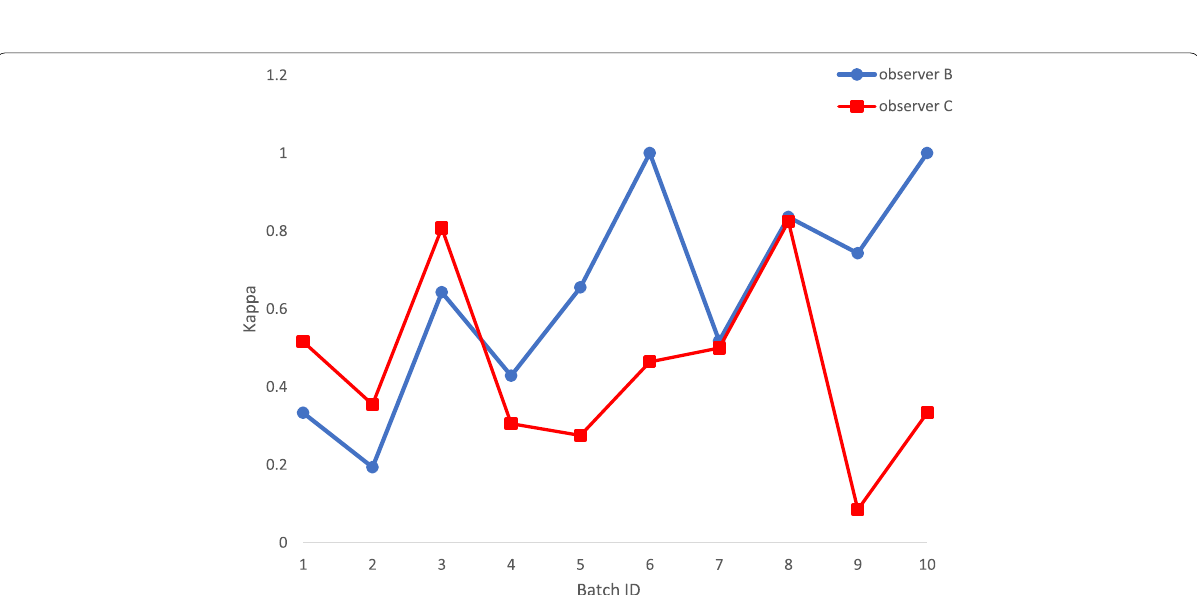
Fig. 4 Kappa values for the variation between the novice observers and the experienced observer on the epiglottis level after each cluster of 10